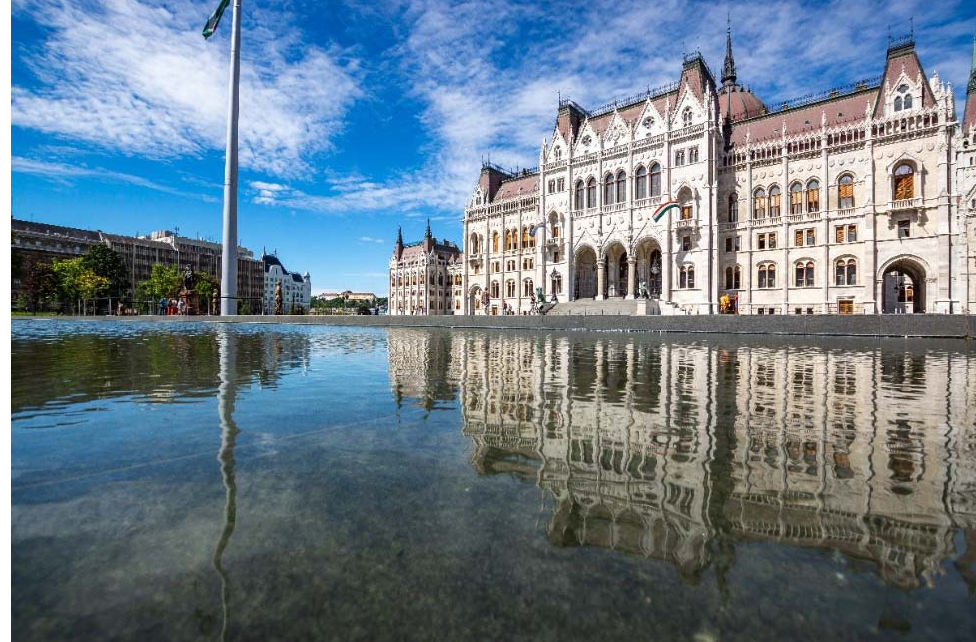
Figure 4. The water surface of the infinity-edge ornamental pool—an open central square. (Photo by the authors, 2018).